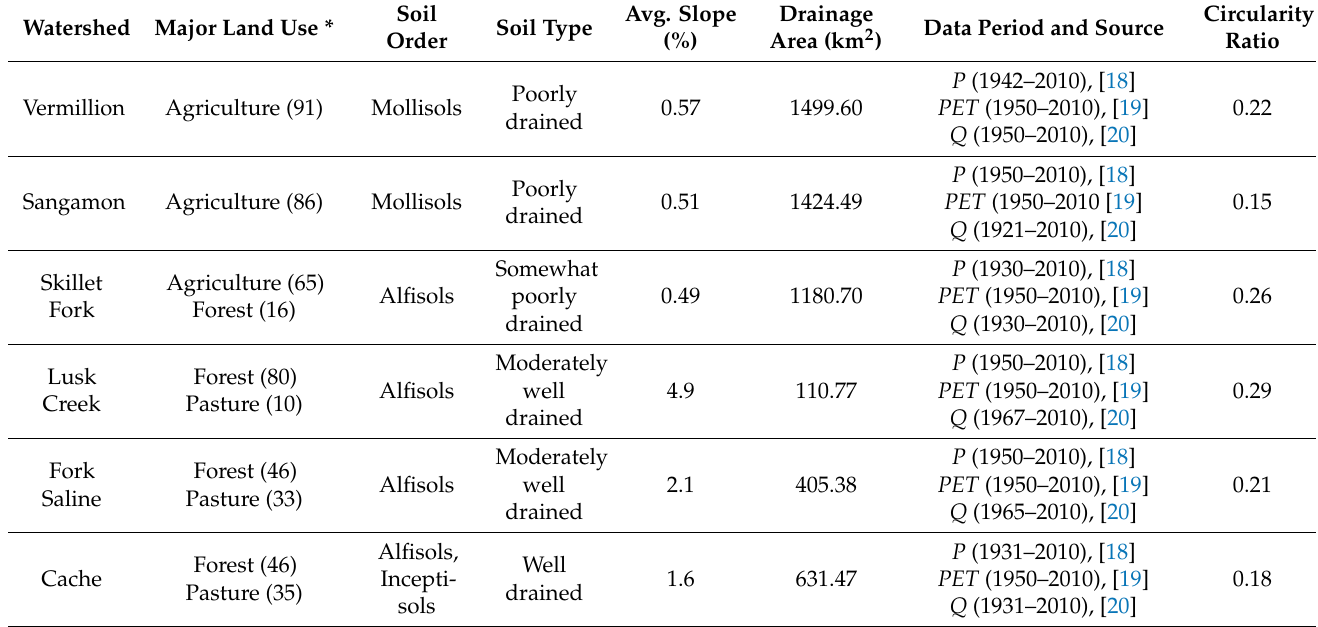
Table 1. Physical characteristics of the sample watersheds along with time period and source of